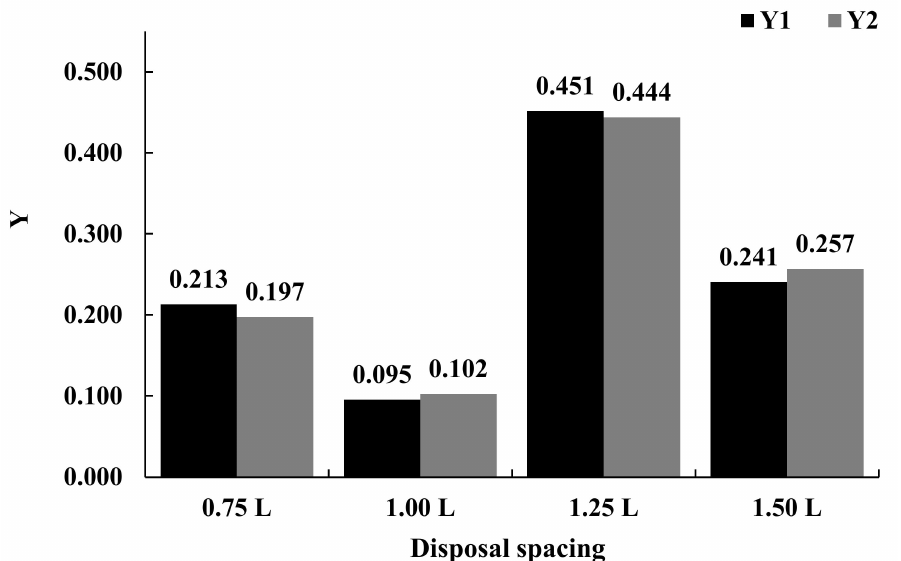
Figure 11. Comprehensive evaluation score of flow field effect of M-shaped unit